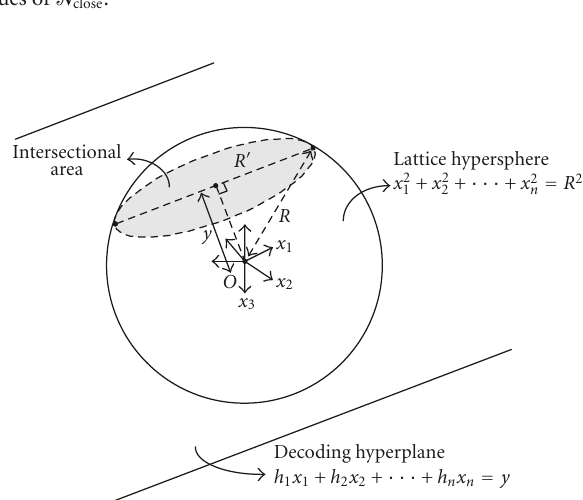
Figure 6: An example showing how N close depends on y assuming the decoding line 2 x 1 +3 x 2 = y and Q = {− 3, − 1,1,3 } . The regions where the decoding line lies are labelled with the corresponding val- ues of N close .